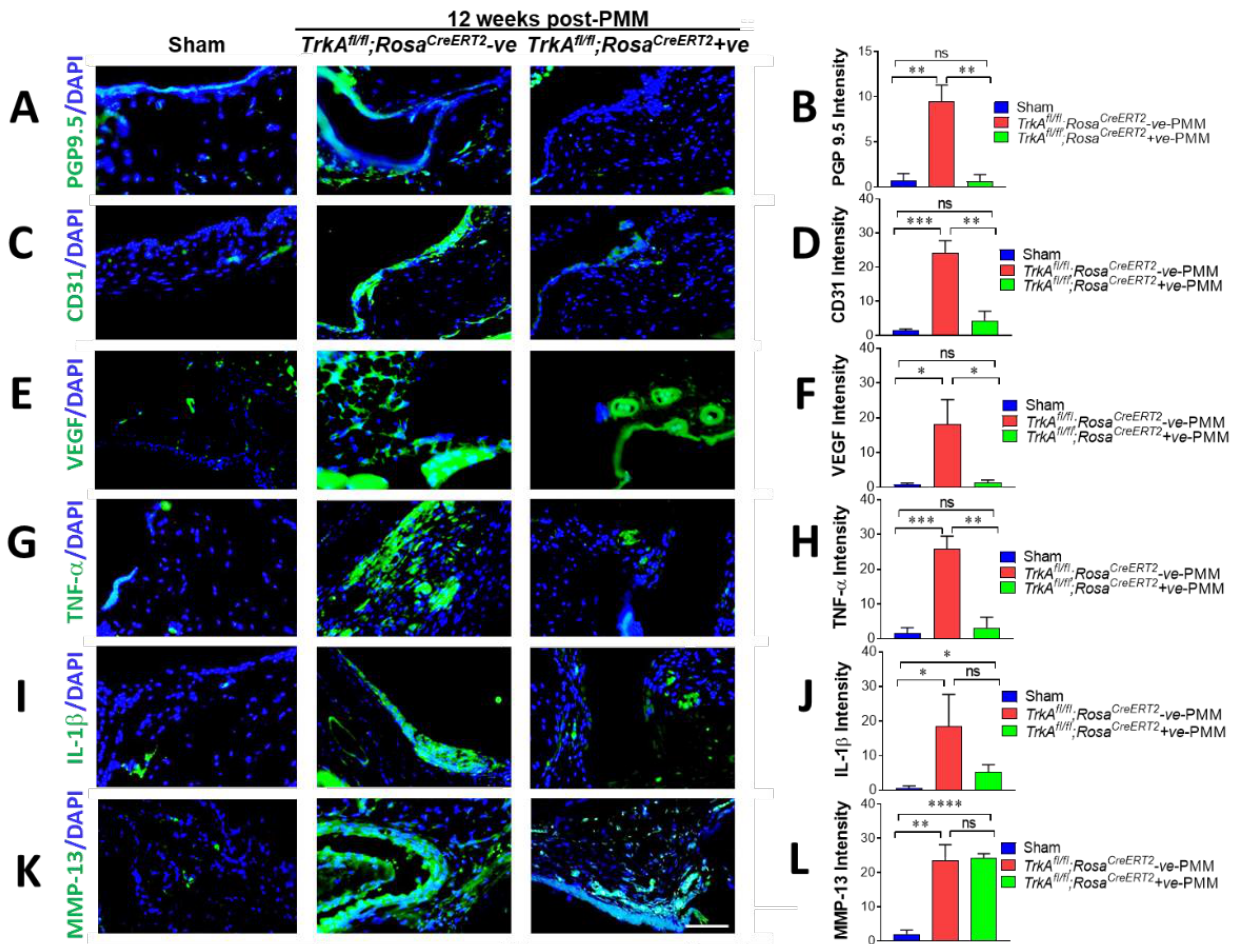
Figure 6. Immunofluorescence staining of peripheral nerve fiber sprouting, angiogenesis factor, pro-inflammatory cytokines, and MMP-13 in osteoarthritis (OA) synovium correlated with decreased joint pain sensation in OA. Reduced PGP9.5 expression in joint tissues indicated less synovial sensory fiber and downregulated neural fiber. ( A ) Representative immunofluorescence images of staining for PGP9.5 (green) in knee joint synovium of TrkA fl/fl ;Rosa CreERT2 -negative ( n = 11) and TrkA fl/fl ;Rosa CreERT2 -positive ( n = 5) mice. ( B ) Quantitative analyses of nerve fiber sprouting. PGP9.5+ nerve fiber density was calculated as the intensity of the nerve fiber area. 4′,6 -Diamidino-2-phenylindole (DAPI) stained nuclei blue. ( C – F ) Reduced angiogenesis factor CD31 ( C ) and VEGF ( E ) and quantification of CD31 ( D ) and VEGF ( F ) expression in joint tissues indicated decreased innervation and angiogenic markers in the knee joint synovium of TrkA -deleted mice after PMM compared to TrkA fl/fl ;Rosa CreERT2 -negative control mice. Quantitative analysis of CD31 ( D ) VEGF ( F ) expression in the synovium. Immunofluorescence staining of TNF- α ( G ) and interleukin (IL)- 1β ( I ) expression of MMP-13 ( K )